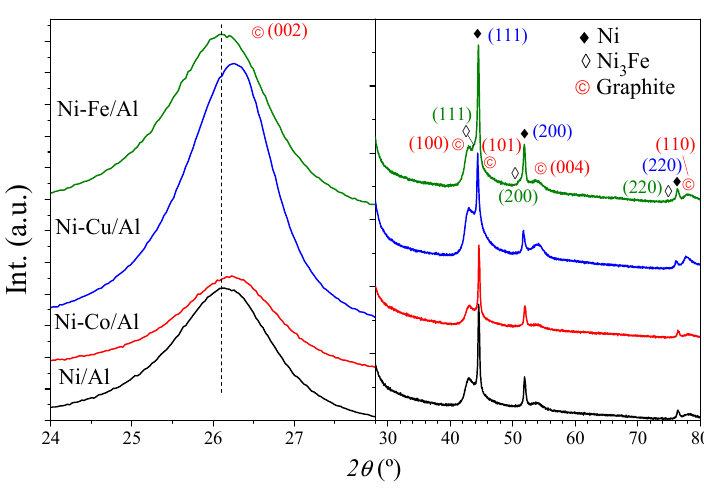
Figure 6. Diffractograms of the carbonaceous products. CDM was carried out in a quartz FBR for 120 min with an operating temperature of 650 °C.